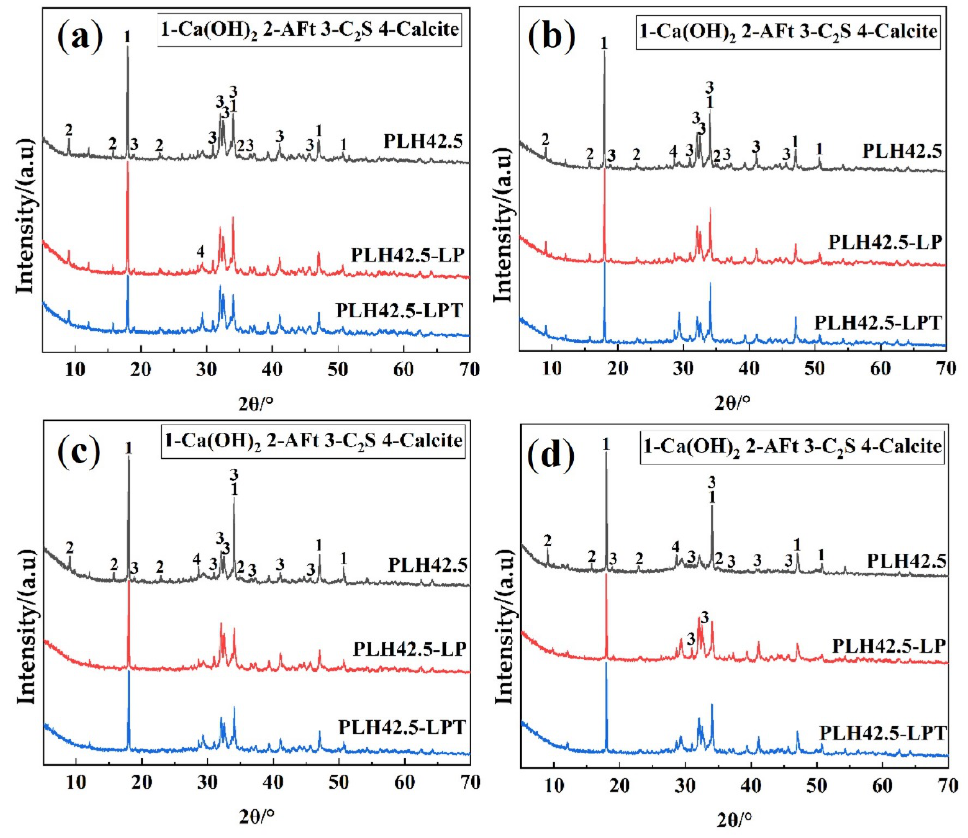
Figure 4. X-ray diffraction pattern of harden pastes curing for ( a ) 3 days, ( b ) 7 days, ( c ) 28 days, and ( d ) 90 days.